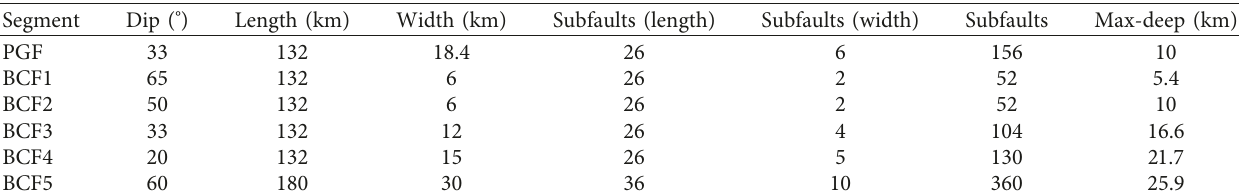
Table 1: Fault parameter.